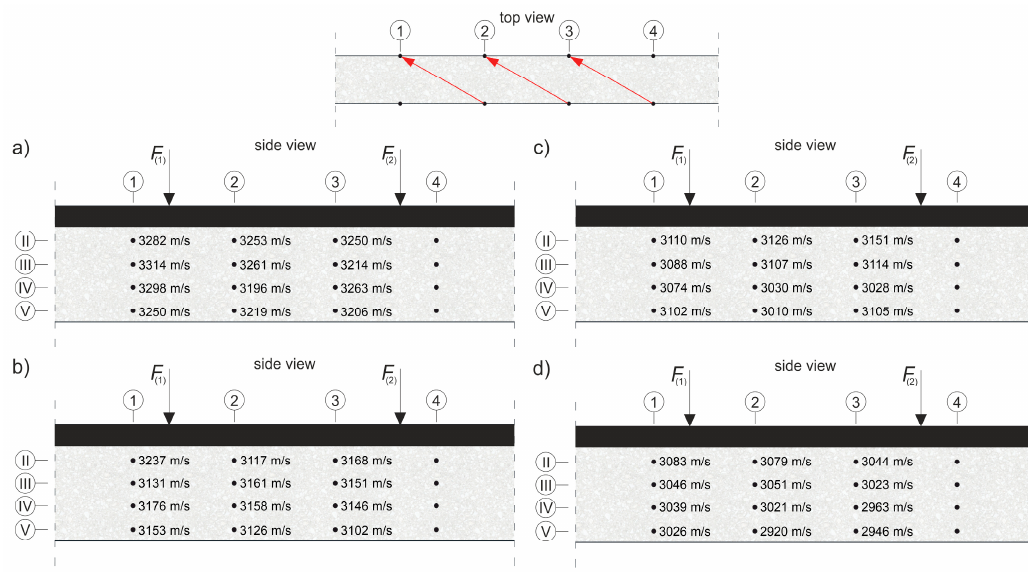
Figure 30. Velocities of the longitudinal waves in beam #2 propagating between the sending and receiving points situated diagonally with one point offset in the right direction, before: ( a ) stage 1, ( b ) stage 2, ( c ) stage 3, ( d ) stage 4.